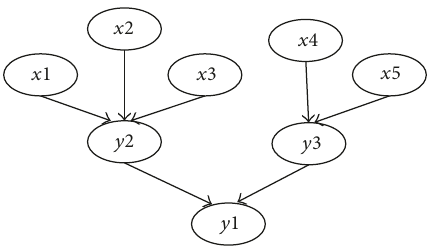
Figure 4: Bayesian network for fault diagnosis when the amplitude of the rotor’s power frequency increased. Table 2: The fault modes and cause for increased amplitude of the rotor’s power frequency.